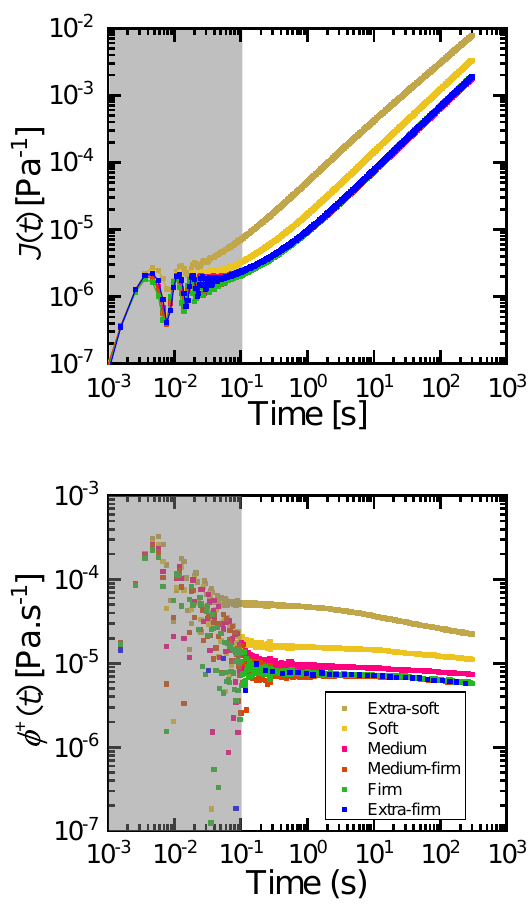
Figure 7: Linear step-stress data from Figure 6 (for σ 0 = 100 Pa). Compared on logscales as (a) creep compliance J ( t ) ≡ 𝛾 ( t ) and (b) σ 0 creep fluidity ϕ ( t ) ≡ ˙ 𝛾 ( t ) . The curves show significantly more flow σ 0 at long time for the softest putties. There is very little difference observable in the creep response for the firmest four putties. (Gray area indicates region of significant system inertia